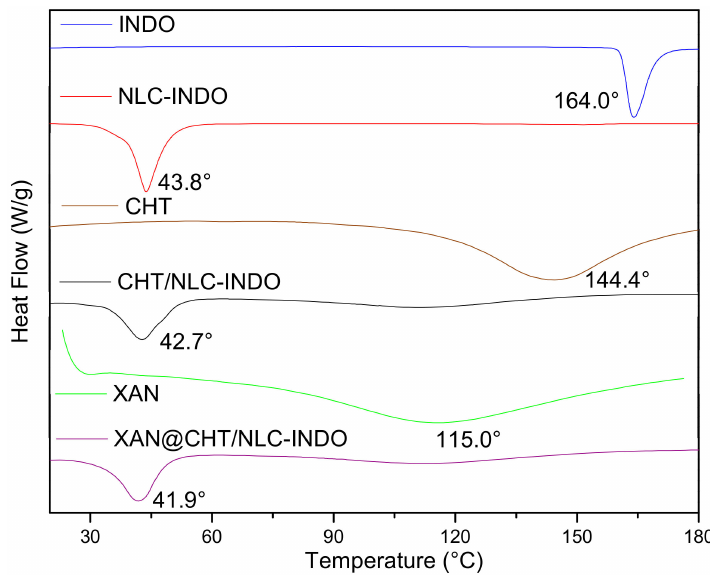
Figure 6. DSC thermograms for indomethacin (INDO), pure chitosan (CHT) and xanthan (XAN), as well as NLC-INDO formulation and CHT/NLC-INDO and XAN@CHT/NLC-INDO nanobeads.